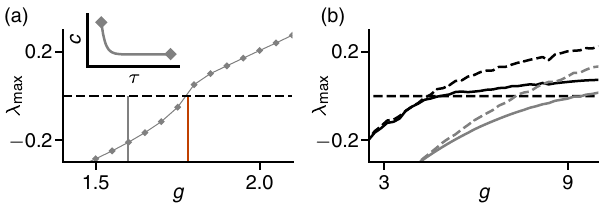
FIG. 5. Transition to chaos for nonvanishing mean coupling and more realistic transfer functions. (a) Rectified-linear transfer function ϕ ð x Þ ¼ max ð x; 0 Þ : Maximum Lyapunov exponent as a function of g measured in simulations (diamonds connected by lines), transition criterion (20) (red vertical line), and necessary condition (18) (gray vertical line) for ¯ g ¼ − 1 and σ ¼ 0 . 5 . The inset shows the autocorrelation function in simulations (solid curve) and c 0 , c ∞ (diamonds) from the self-consistent solution for g ¼ 1 . 5 . (b) Leaky integrate-and-fire neuron transfer function: Maximum Lyapunov exponent (solid curve) and eigenvalue radius ρ minus one (dashed curve) as a function of g for the autonomous (black) and driven cases (gray). The network size is N ¼ 1000 , and ¯ g ∈ ½ − 0 . 05 ; − 30 (cid:2) varies linearly with g . Other 0 . 1 , ν 600 Hz, and σ ¼ 7 . 1 . Param- parameters are J ext ¼ ext ¼ eters of the transfer function (for definitions, see, e.g., Eq. (27) in 20 ms, synaptic time constant Ref. [48]) are as follows: τ m ¼